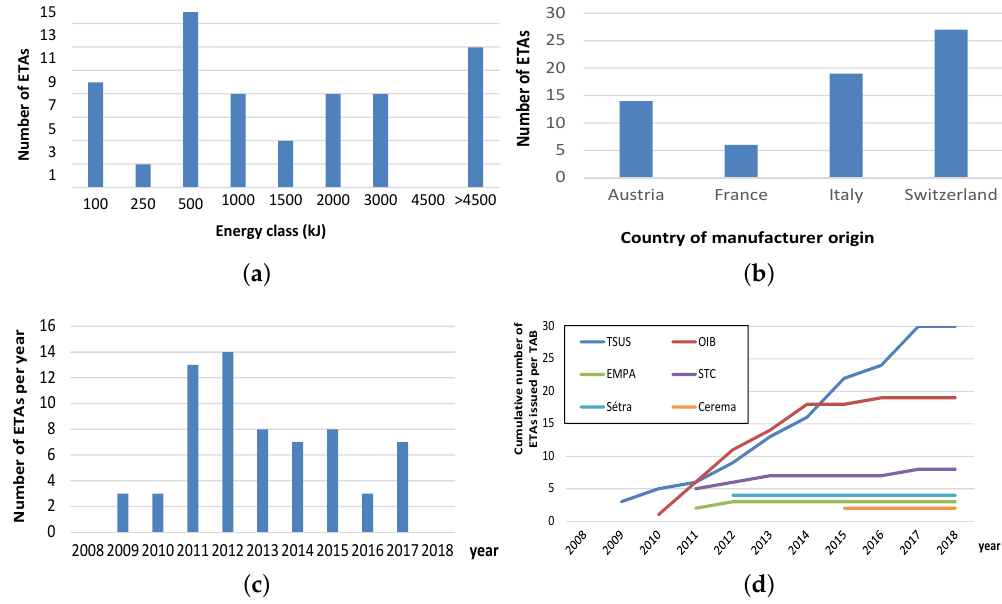
Figure 2. Issued ETAs ( a ) sorted according to their energy class, ( b ) sorted according country of origin, ( c ) sorted per reference year (year of ETA document number), and ( d ) linked to the handling Technical Approval Body (TAB) located in Slovakia (TSUS), Austria (OIB), Switzerland (EMPA), France (Setra, Cerema) and Italy (STC).